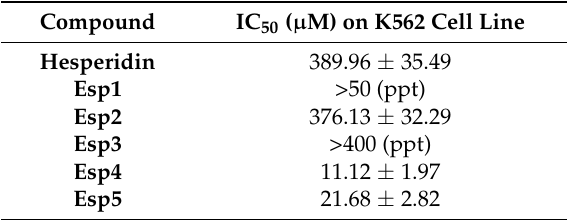
Figure 1. T120 Stability data of formulations with hesperidin and its derivatives (results are percentage decrease compared to T0). Table 5. Effects of hesperidin and its derivatives on cell proliferation of K562 cells (the data are the mean of three independent experiments ±